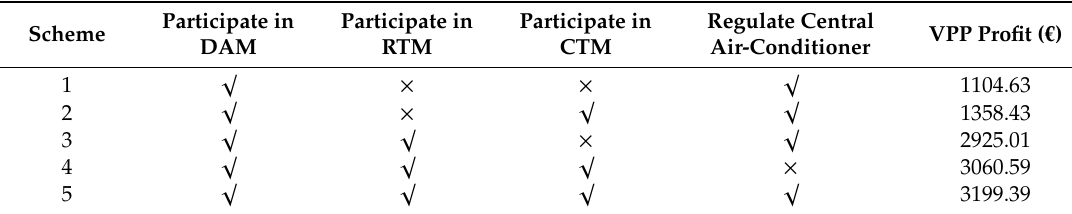
Table 1. Comparisons of VPP profit obtained under di ff erent